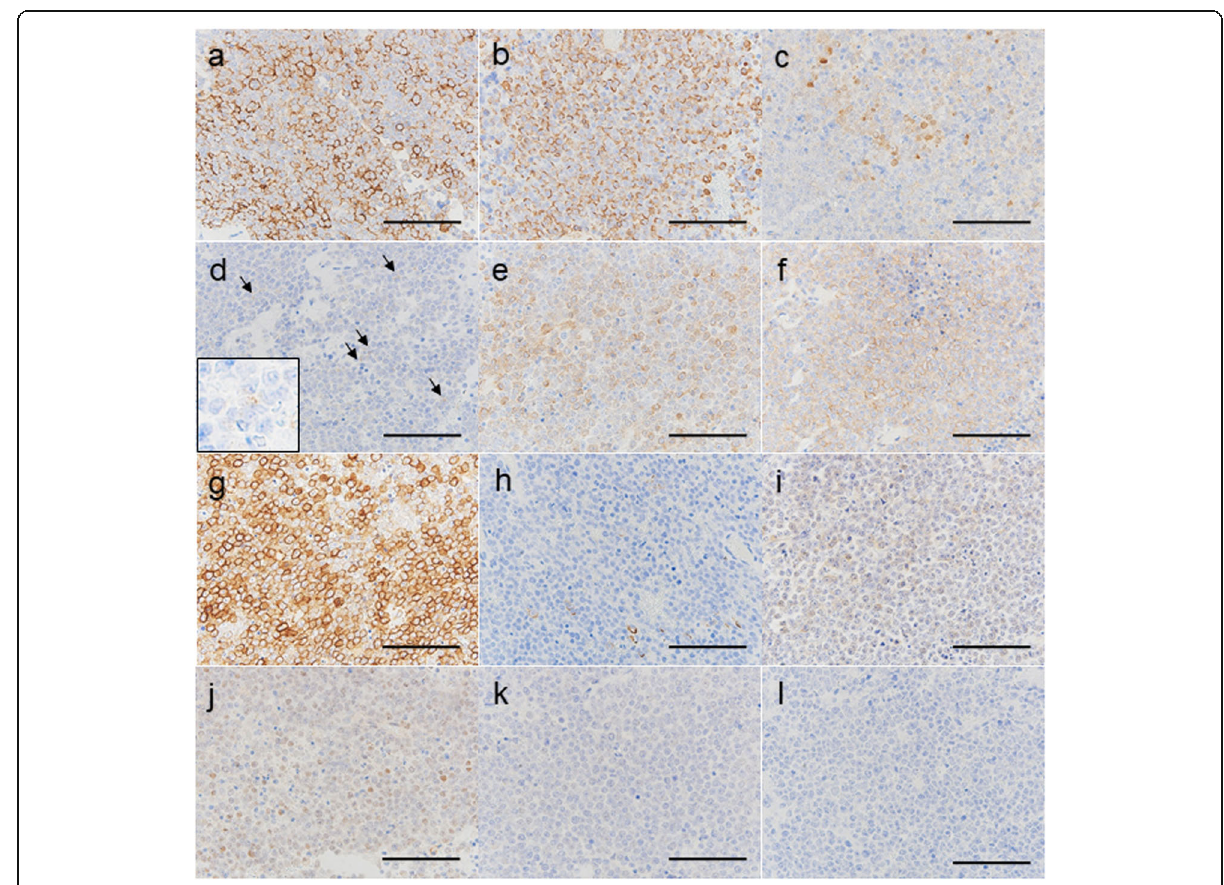
Fig. 3 Representative immunohistochemical findings of the pulmonary tumor. Tumor cells were positive to various degrees for EMA ( a ), Vimentin ( b ), NSE ( c ), Chromogranin A ( d arrows and inset), BCL-2 ( e ), CD99 ( f ), HHF35 ( g ), Desmin ( h ), Calponin ( i ) and SALL4 ( j ). P63 ( k ) and p40 ( l ) were negative. Bar, 100 μ